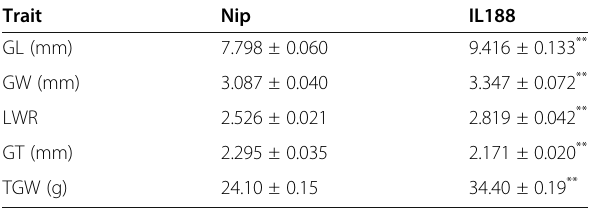
Nip Nipponbare, GL grain length, GW grain width, LWR the ratio of grain length to grain width, GT grain thickness, TGW thousand grain weight. ** indicate significance at P